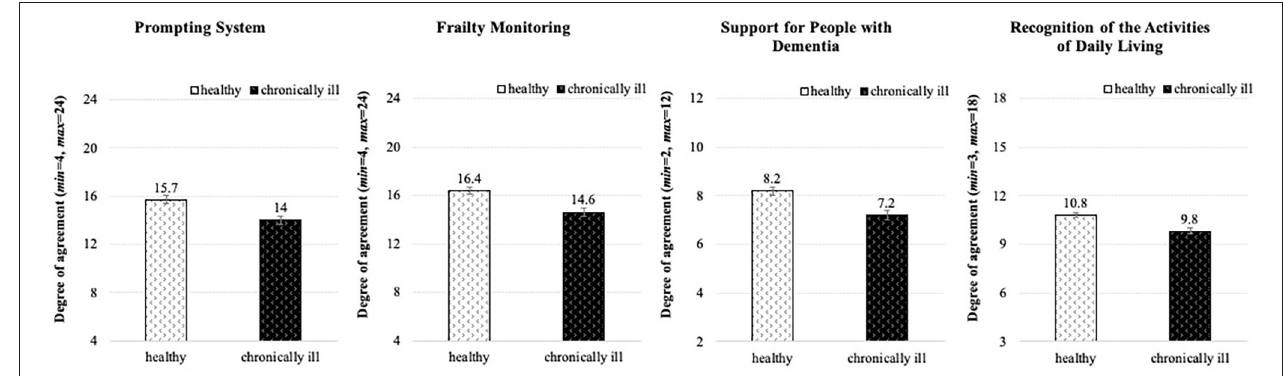
FIGURE 9 | Effect of the health status on acceptance of using specific assistive applications and functions ( N =